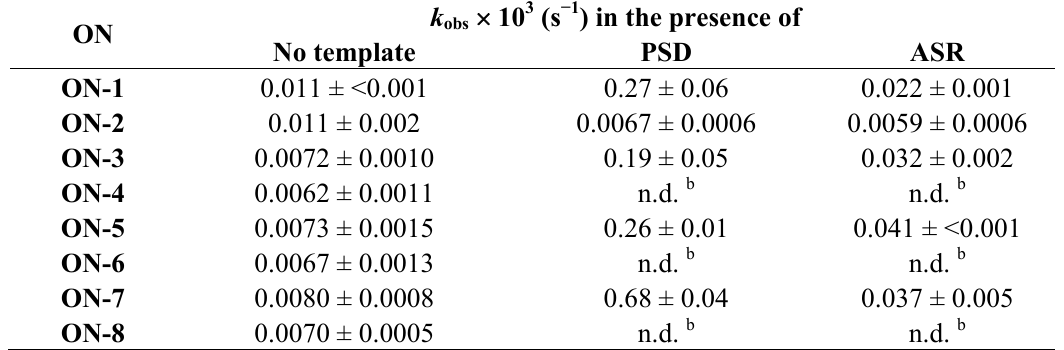
Table 3. Observed pseudo first-order rate constants of each oligonucleotide at pH 4.0, 20 °C a